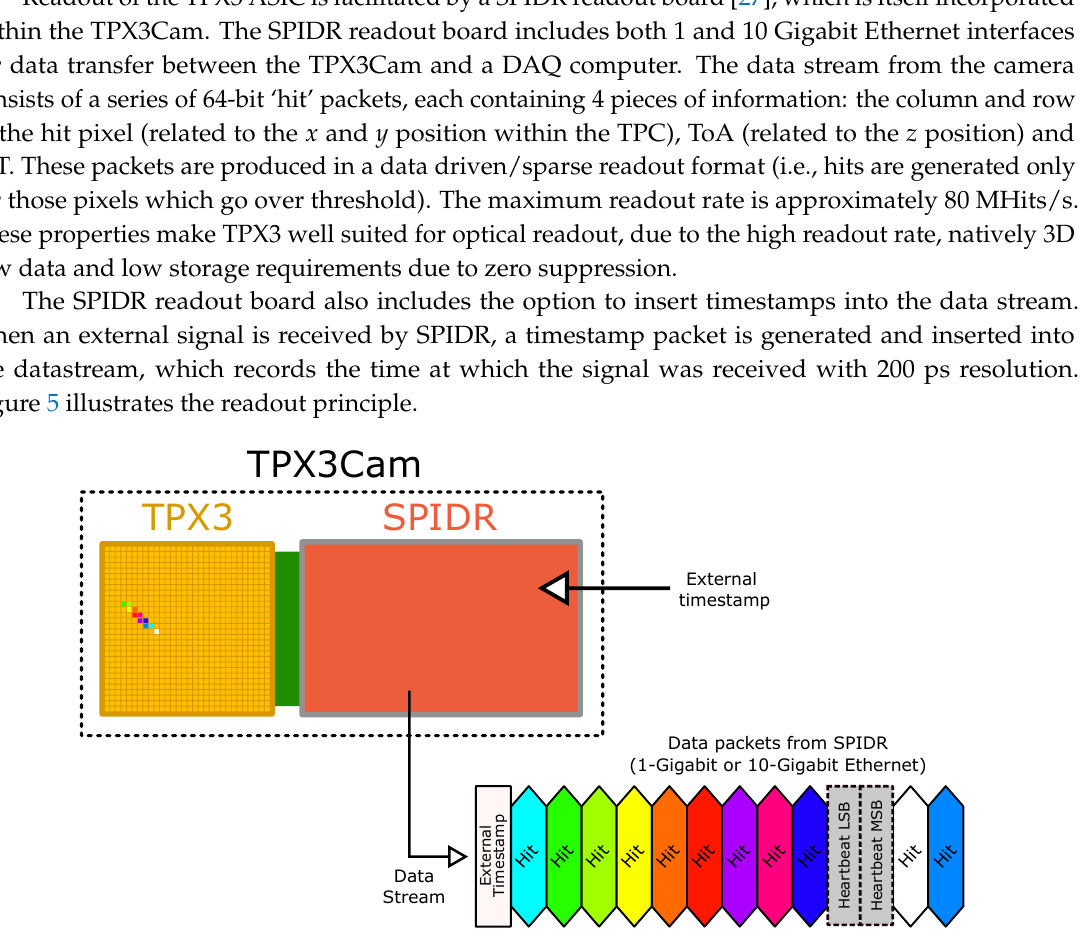
Figure 5. General overview of the operation of the SPIDR readout board. A continuous stream of data packets is generated by the SPIDR readout board, encoding all of the information taken during operation, including the external timestamps. The packets are transferred to storage via a 1 Gigabit Ethernet connection and are then parsed and analysed offline. A more detailed description can be found in